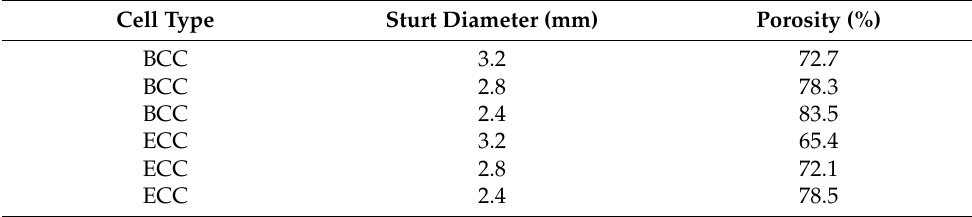
Table 1. The porosity of the six cubic based lattice